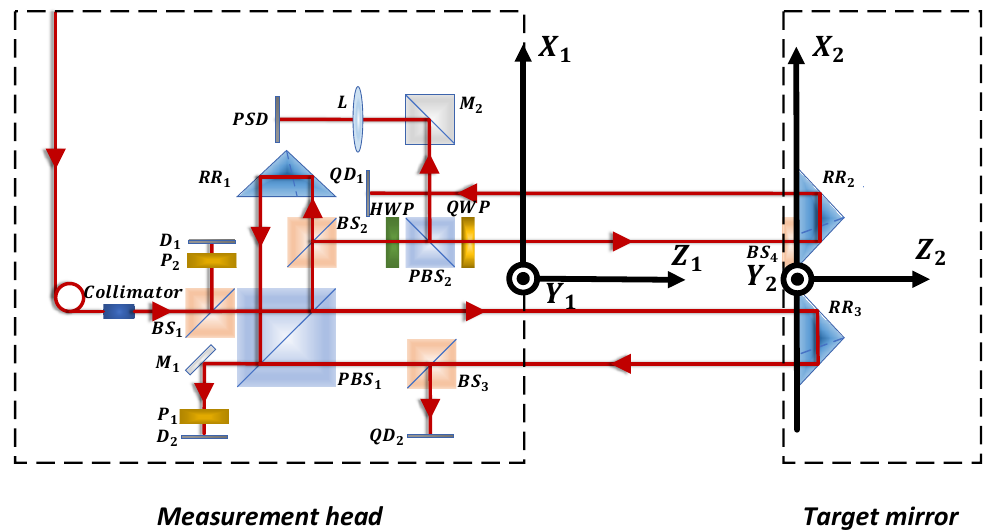
Figure 4. Coordinate system for the measurement head and target mirror.